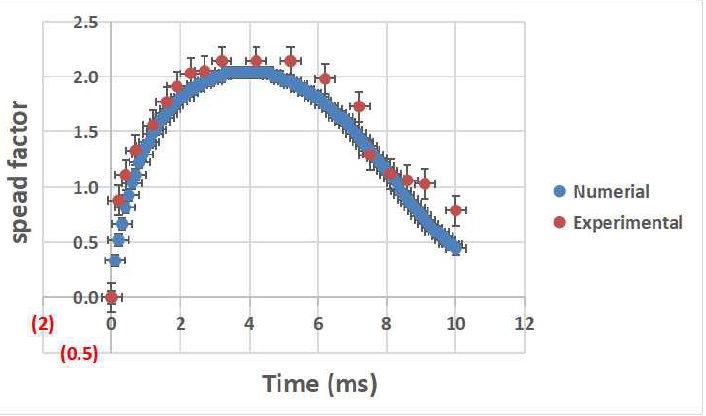
Figure 9. Spread factor evolution for the Tin drop impact. The standard error is shown as well.